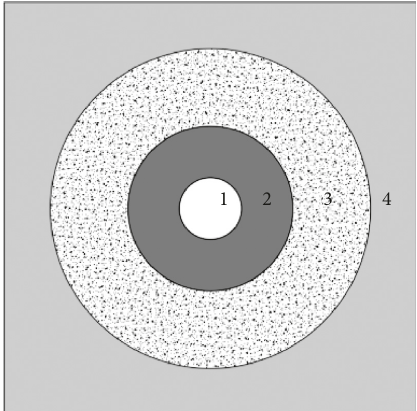
Figure 1: Strong-soft-strong structural model. 1, roadway; 2, internal strong structure (6 ∼ 12 m); 3, intermediate soft structure (8 ∼ 10 m); 4, external strong structure (the surrounding